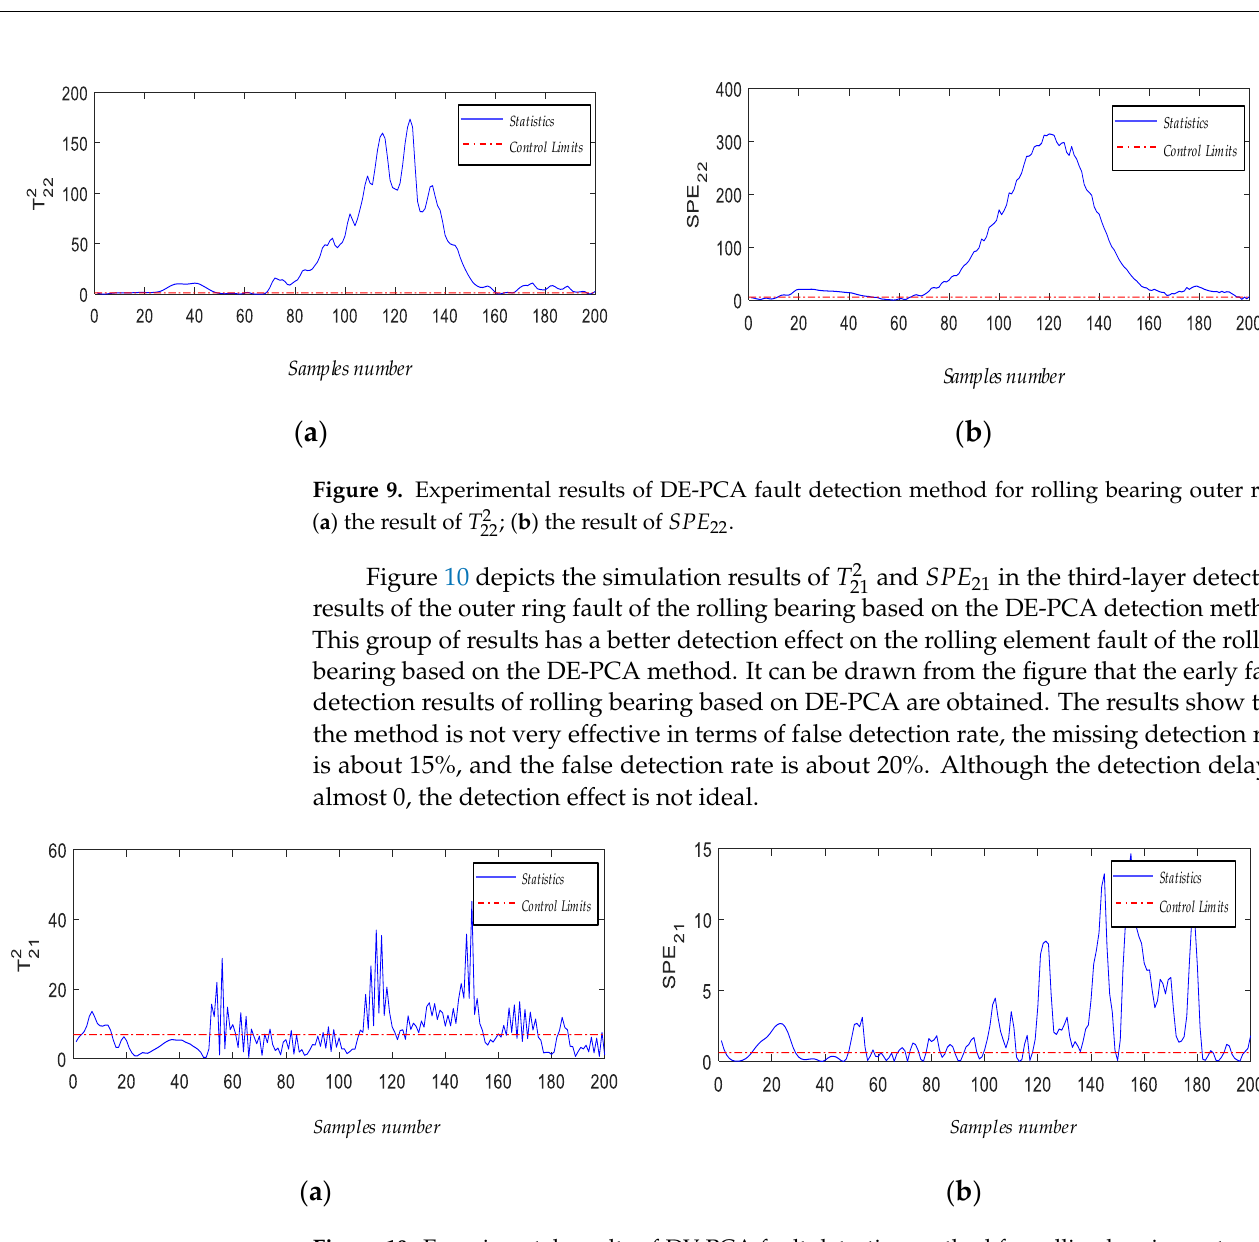
Figure 10. Experimental results of DV-PCA fault detection method for rolling bearing outer ring: ( a ) the result of T 2 ; ( b ) the result of SPE 21